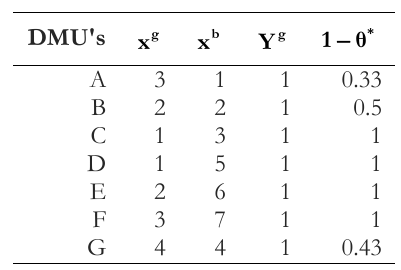
Table 1. The inputs and outputs data for 7 DMUs.